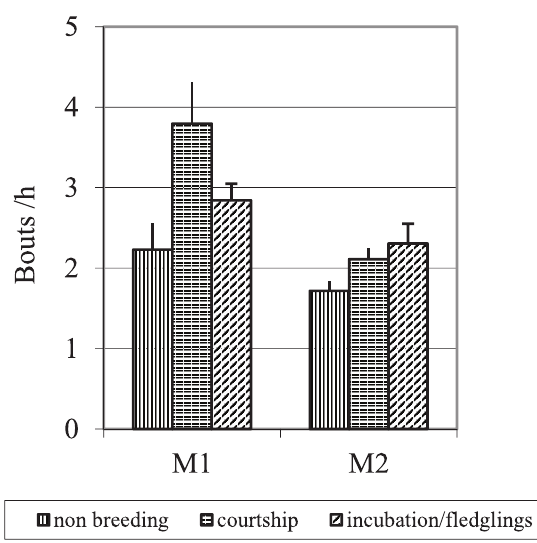
Figure 9. Effect of the social phase on the number of guarding bouts by M and by M . 1 2